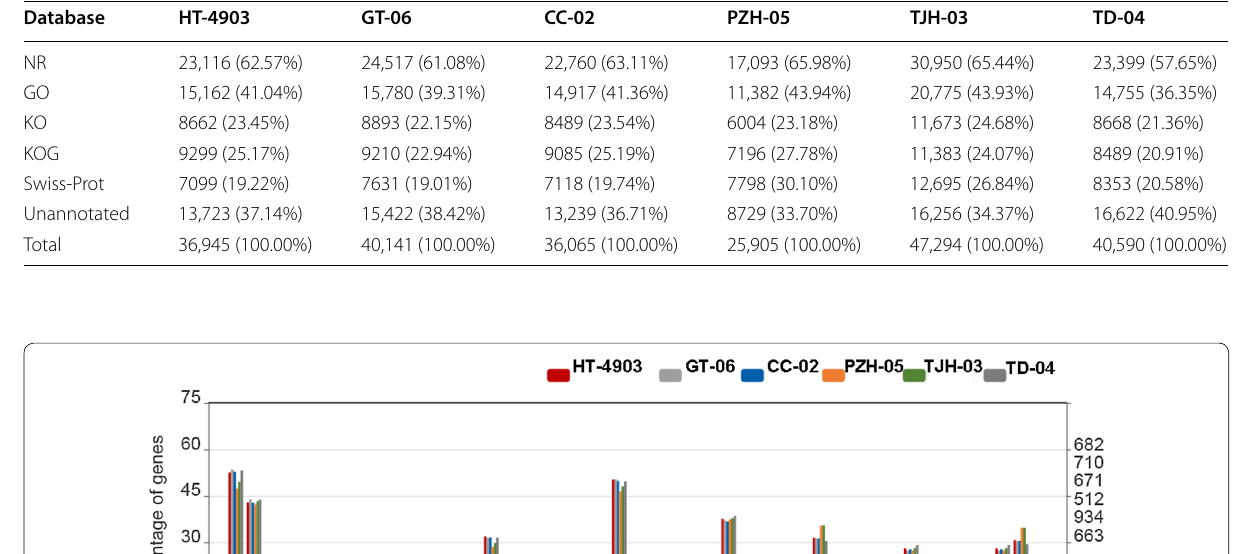
Table 2 Functional annotations of the de novo transcriptomes for HT-4903, GT-06, CC-02, PZH-05, TJH-03 and TD-04